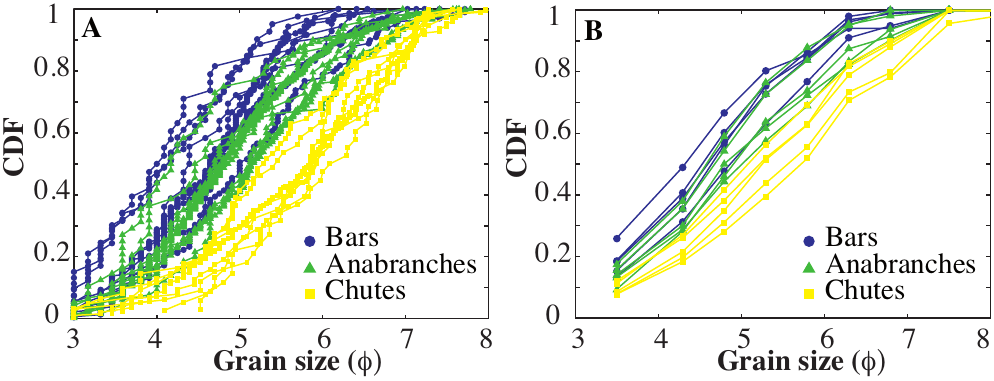
Fig. 5. Individual grain-size distributions of (a) the surface and (b) the surface layer of the sampled elements. Each kind of element is characterized by a range of grain sizes with an overlap between the bars (blue dots) and the anabranches (green triangles) distributions. In contrast, the chute distributions (yellow squares) clearly differ, indicating that chutes are always coarser-grained than anabranches and bars.